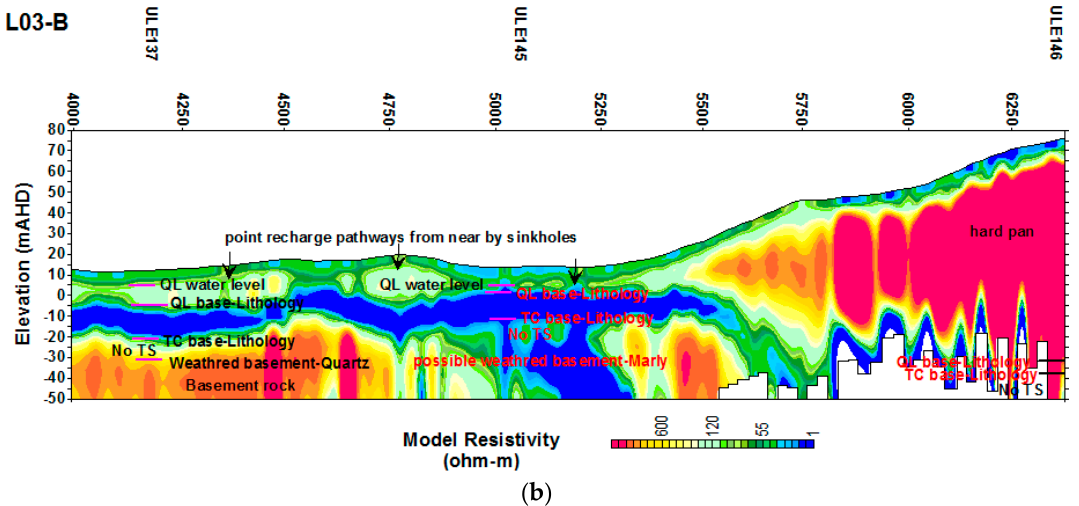
Figure 11. TEM sections for LO3; ( a ) LO3-A; ( b ) LO3-B.